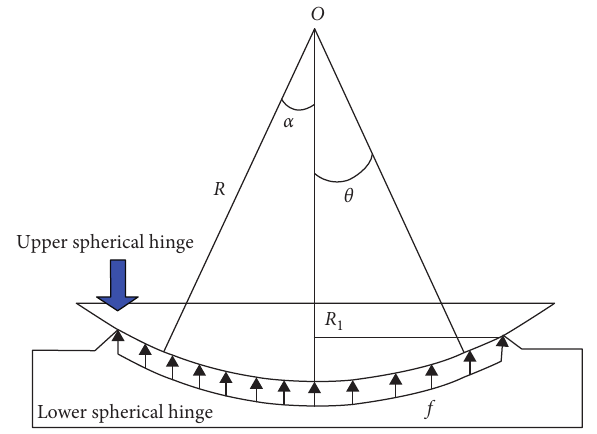
Figure 16: Stress distribution of spherical hinge.